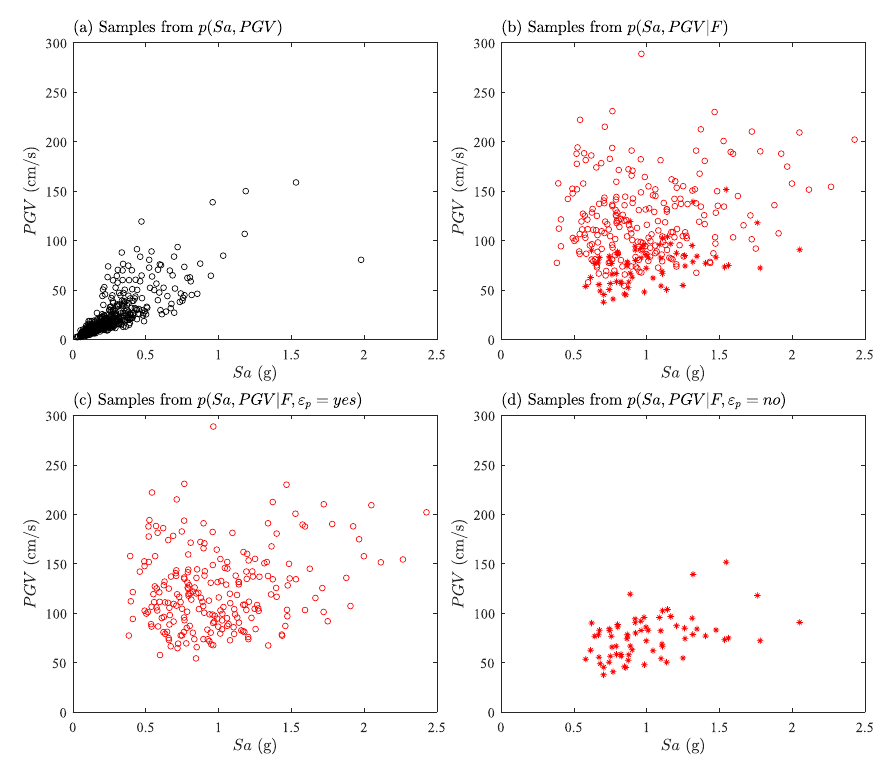
Figure 17. Samples from ( a ) p ( Sa , PGV ) , ( b ) p ( Sa , PGV | F ) , ( c ) p ( Sa , PGV | F , ε p = yes ) , and